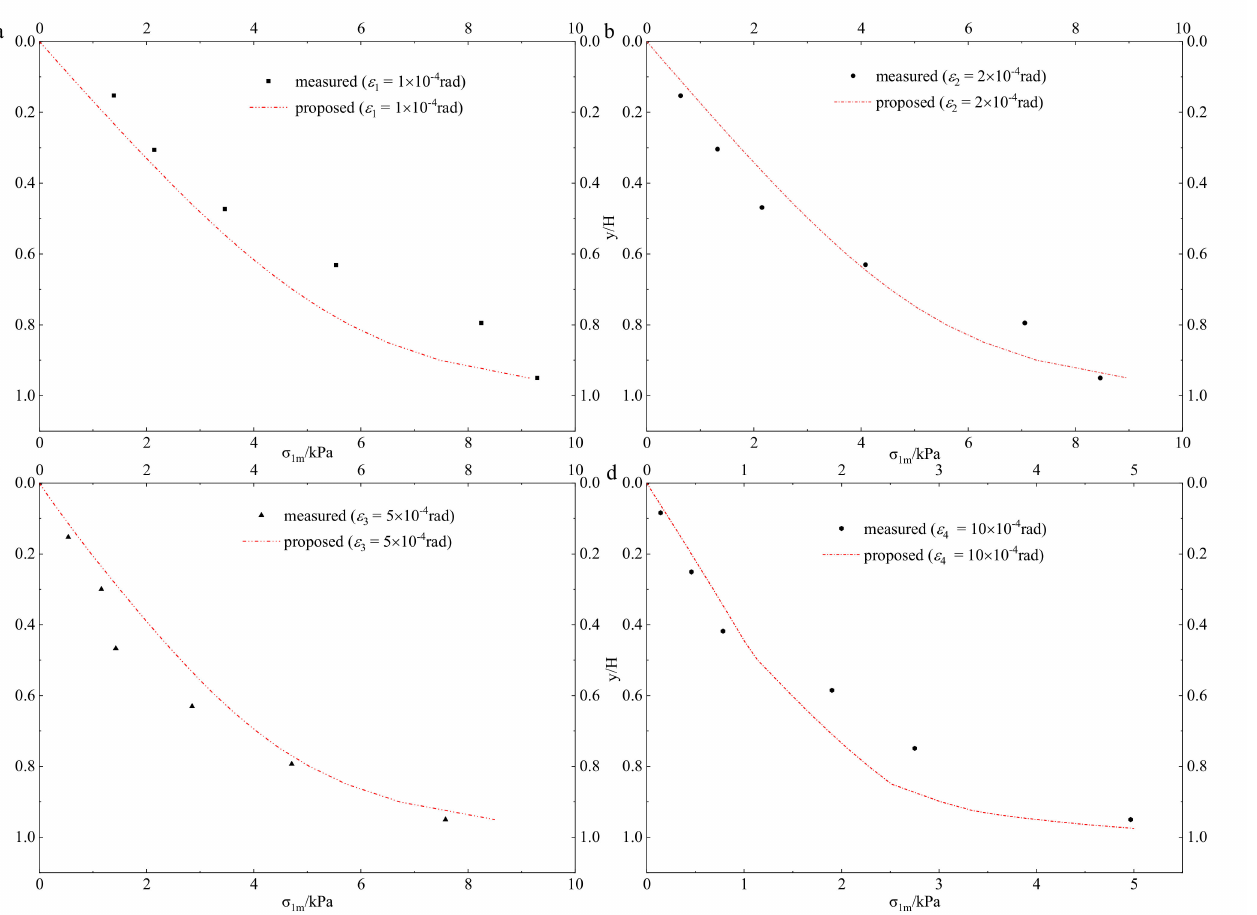
Figure 4. Comparisons between existing theoretical solutions and experimental data with varying rotation angles: ( a ) ε 1 = 1 × 10 − 4 rad of Fang; ( b ) ε 2 = 2 × 10 − 4 rad of Fang; ( c ) ε 3 = 5 × 10 − 4 rad of Fang [19]; ( d ) ε 4 = 5 × 10 − 4 rad of Smita